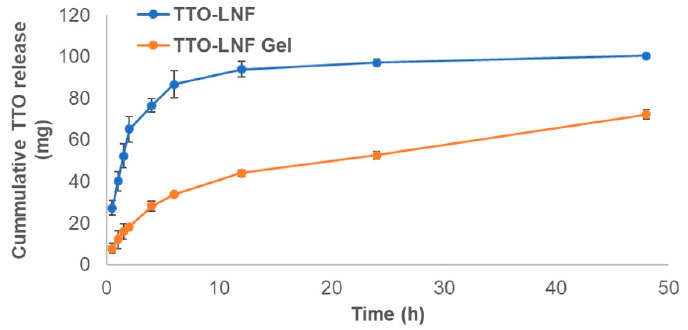
Figure 3. In vitro release of tea tree oil (TTO) from TTO-LNF gel and TTO-LNF.